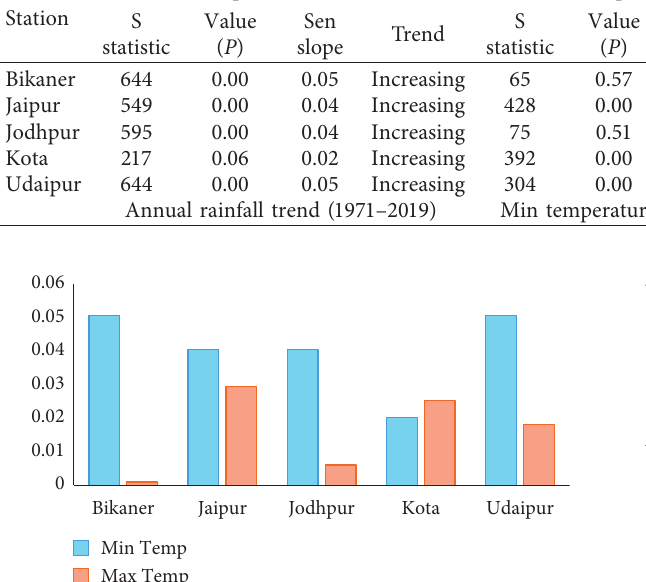
Table 5: Trend analysis of temperature and rainfall using the MK test (at 5% level of significance). Station